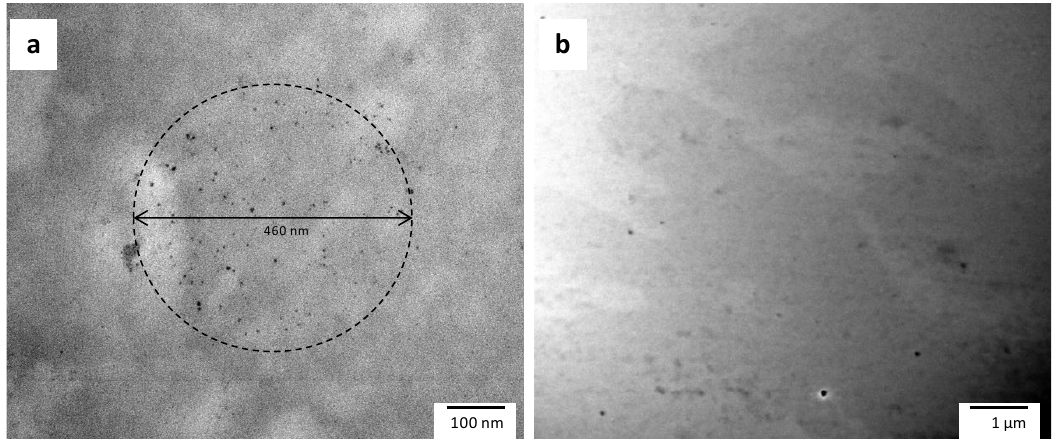
Figure 2. Transmission electron microscopy (TEM) micrographs of ultramicrotomed silver-containing materials: ( a ) in PHBVs/AgNPs; ( b ) in the active multilayer film. The dashed line in the Figure 2a shows a group of AgNPs whose diameter matches with the fiber’s diameter of 0.46 µm.